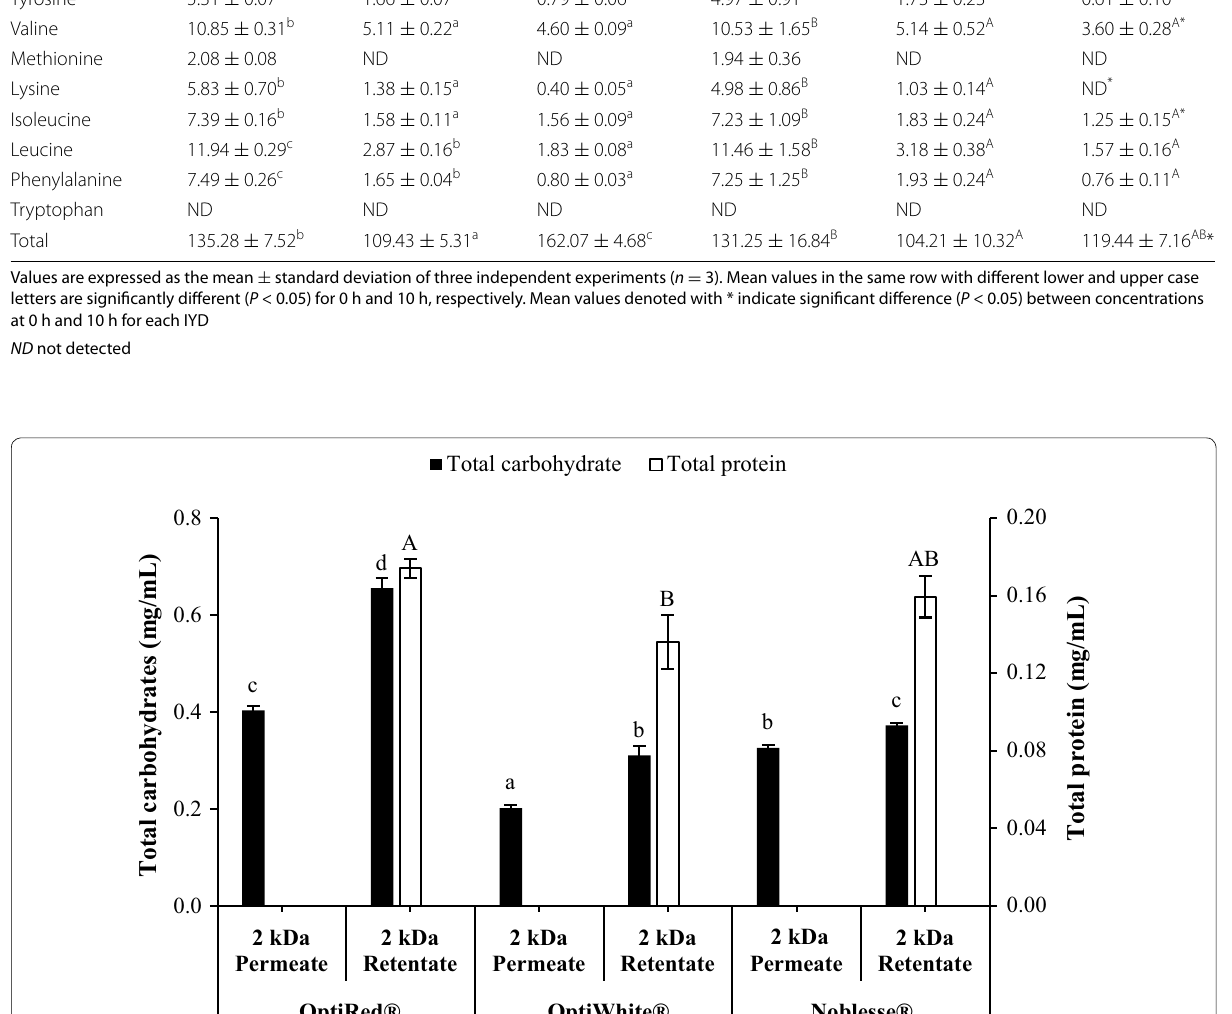
Fig. 5 Total carbohydrate and protein concentrations of 2 kDa membrane permeates and retentates of IYD supernatants. Different lowercase and uppercase letters indicate significant differences ( P < 0.05) for total carbohydrates and proteins, respectively. Values are the mean of triplicate experi- ments ( n 3), with error bars representing the standard deviations of the mean =